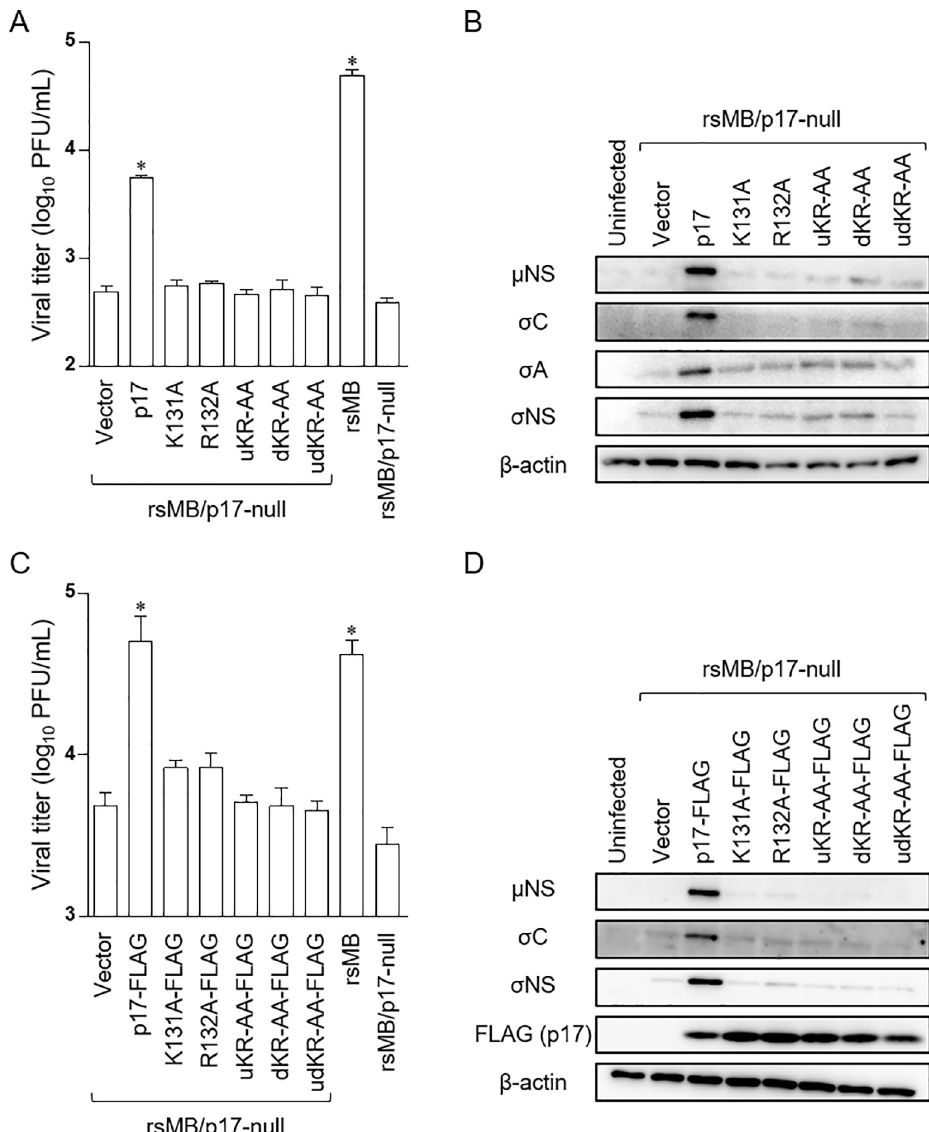
Fig 6. The two bipartite basic amino acid sequences in the p17 C-terminus play an important role in NBV replication in DemKT1 cells. (A, C) Viral titers of rsMB/p17-null in DemKT1 cells expressing wild-type and mutant p17 proteins (A) or FLAG-tagged wild-type and mutant p17 proteins (C) . Cells were infected with rsMB/p17-null at an MOI of 0.1 PFU/cell (n = 3) at 24 h post-transfection, and viral titers were determined by plaque assay at 24 h post- infection. Results are expressed as the mean of three samples. Error bars indicate standard deviations. Significant differences compared to the vector control are indicated by asterisks. � p < 0.05 (Dunnett’s test). (B, D) Electrophoretic analysis of viral proteins in rsMB/p17-null-infected cells expressing wild-type and mutant p17 proteins (B) or FLAG- tagged wild-type and mutant p17 proteins (D) . Wild-type or mutant p17 expression plasmids were transfected into DemKT1 cells and infected with rsMB/p17-null at an MOI of 1 PFU/cell at 10 h post-transfection. Cells were lysed at 16 h post-infection. Cell lysates were subjected to immunoblotting using antibodies raised against NBV proteins or β -